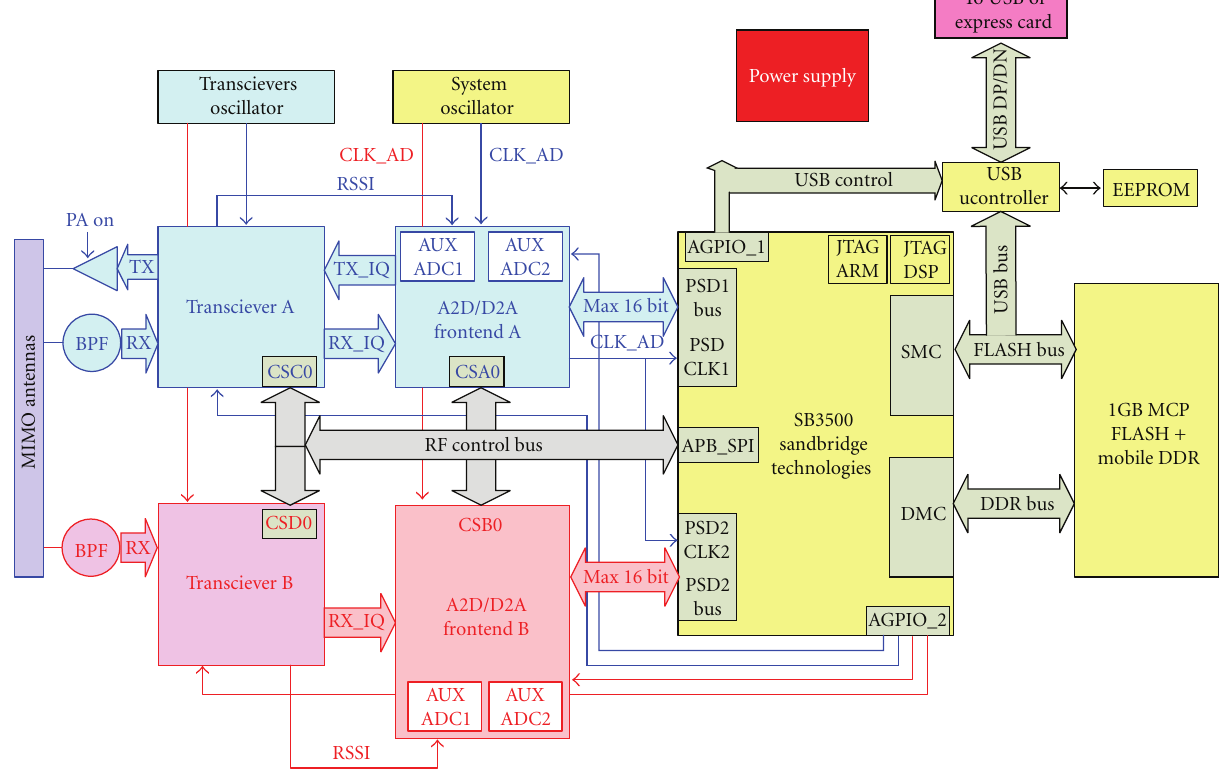
Figure 1: SDR platform block